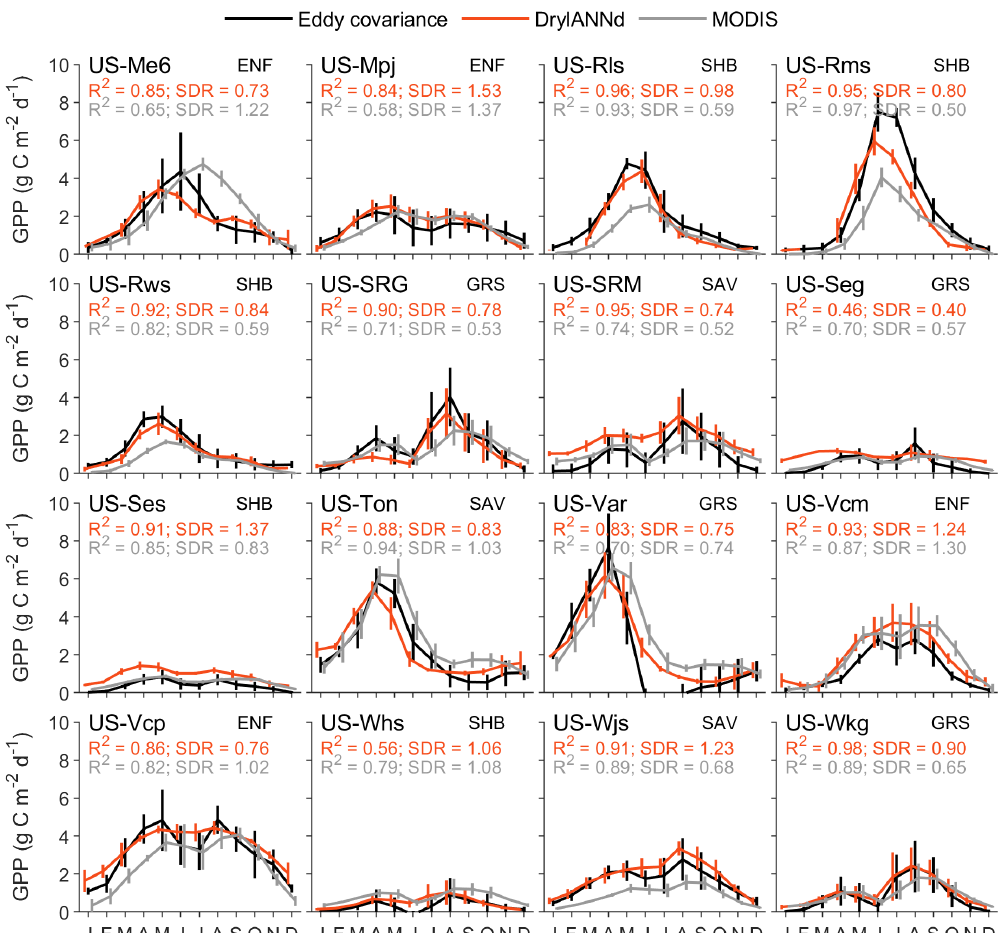
Figure 5. Mean ( ± 1 standard deviation) seasonality of eddy covariance GPP (black), DrylANNd GPP (red), and MODIS GPP (gray) at the 16 sites with complete flux records. Monthly means and standard deviations for all three datasets were estimated using all available observations during the period 2015–2020. Standard deviation ratio (SDR) < 1 indicates that the model underestimated the magnitude of seasonal variability, and SDR > 1 indicates that the model overestimated the magnitude of seasonal